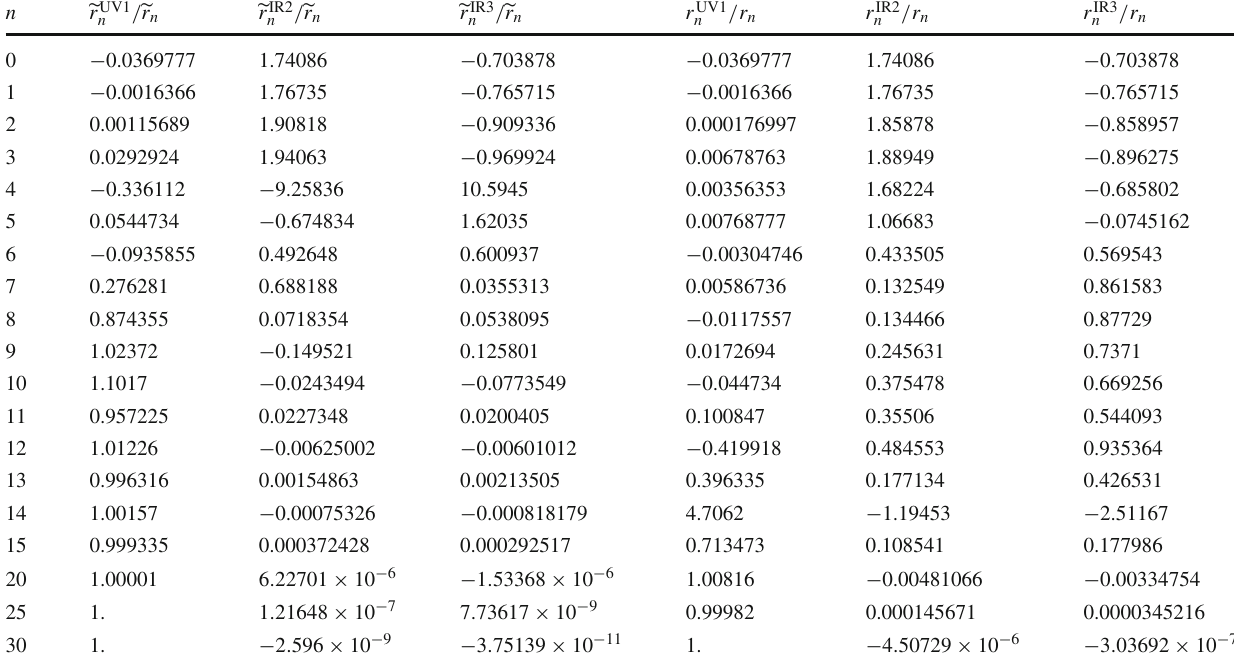
Table 9 The ratios of (cid:8) r X n / (cid:8) r n and r X n / r n for the separate renormalon contributions X= UV1, IR2, IR3 ( κ = 1) to the expansion coefficients of the moment a ( 2 , 1 ) (σ m ) ( D = 0 ) . See the text for